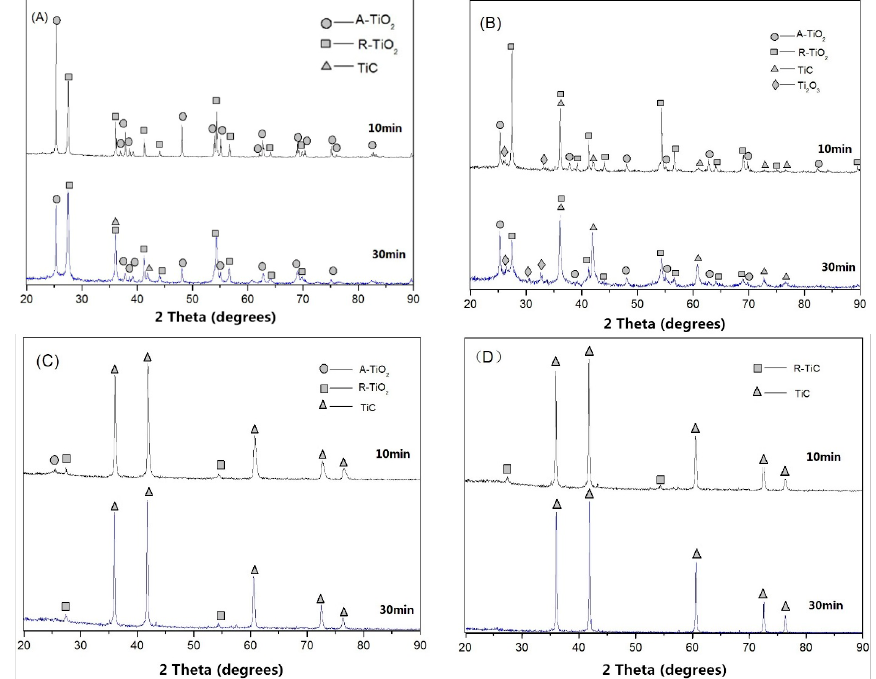
Figure 2. X-ray diffractometer (XRD) patterns of the synthesized samples at various